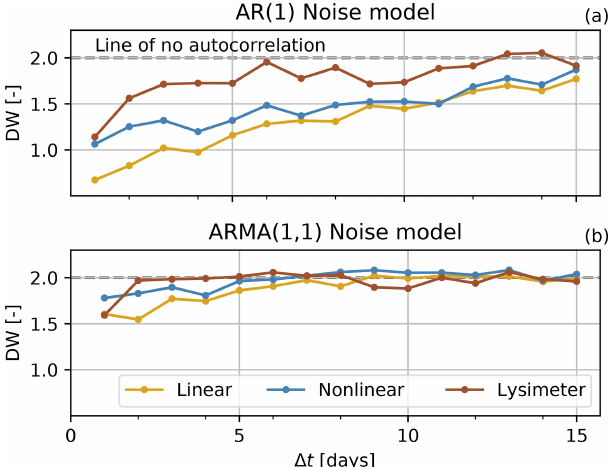
Figure 5. Durbin–Watson (DW) statistics for models calibrated on groundwater levels with an increasing interval ( (cid:49)t ) up to 15d, using an AR(1) noise model (a) or an ARMA(1,1) noise model (b) .